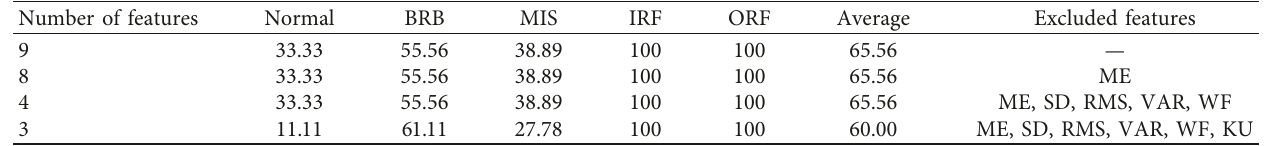
Table 4: Classification accuracies of the vibration signal (%).